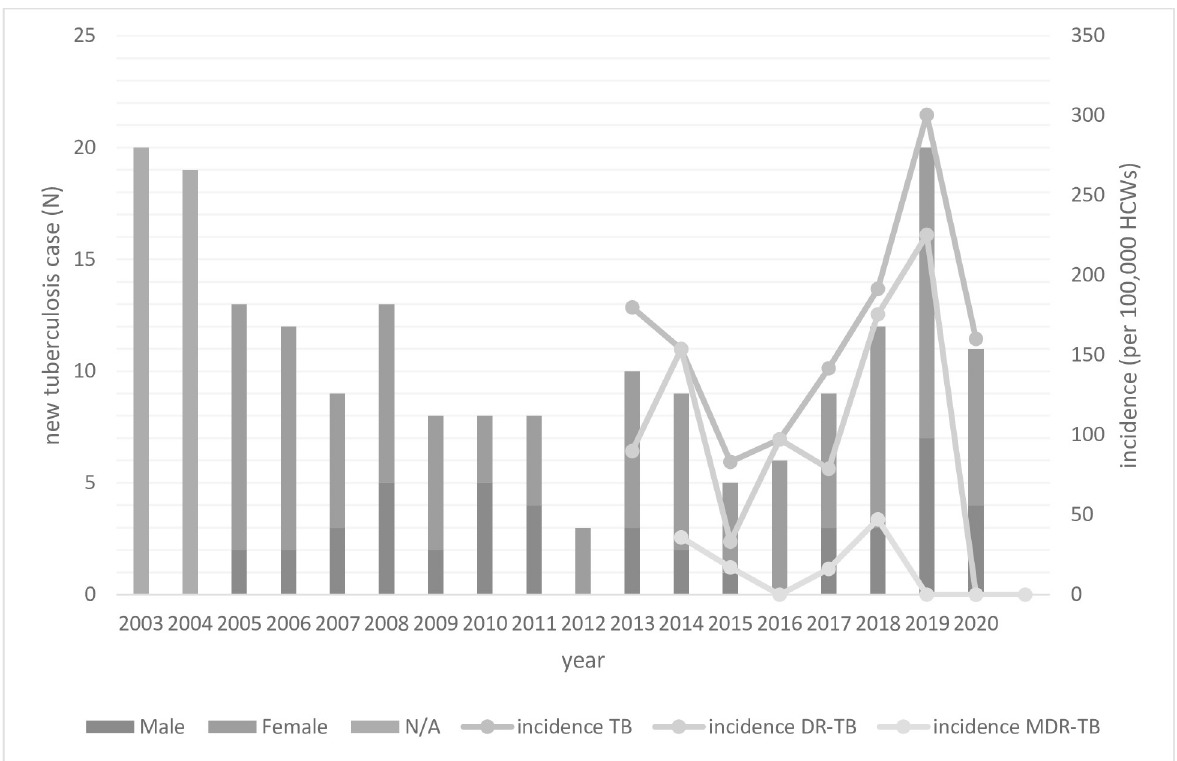
Fig 1. New tuberculosis cases, incidence of overall TB disease, DR-TB, and MDR-TB in HCWs at KCMH from 2013–2020. TB: Tuberculosis, DR-TB: Ddrug- resistant tuberculosis, MDR-TB: Multi-drug resistant tuberculosis, HCWs: Healthcare workers, KCMH: King Chulalongkorn Memorial Hospital, N/A: Not available. � incidence per 100,000 HCWs was calculated from 2013–2020.